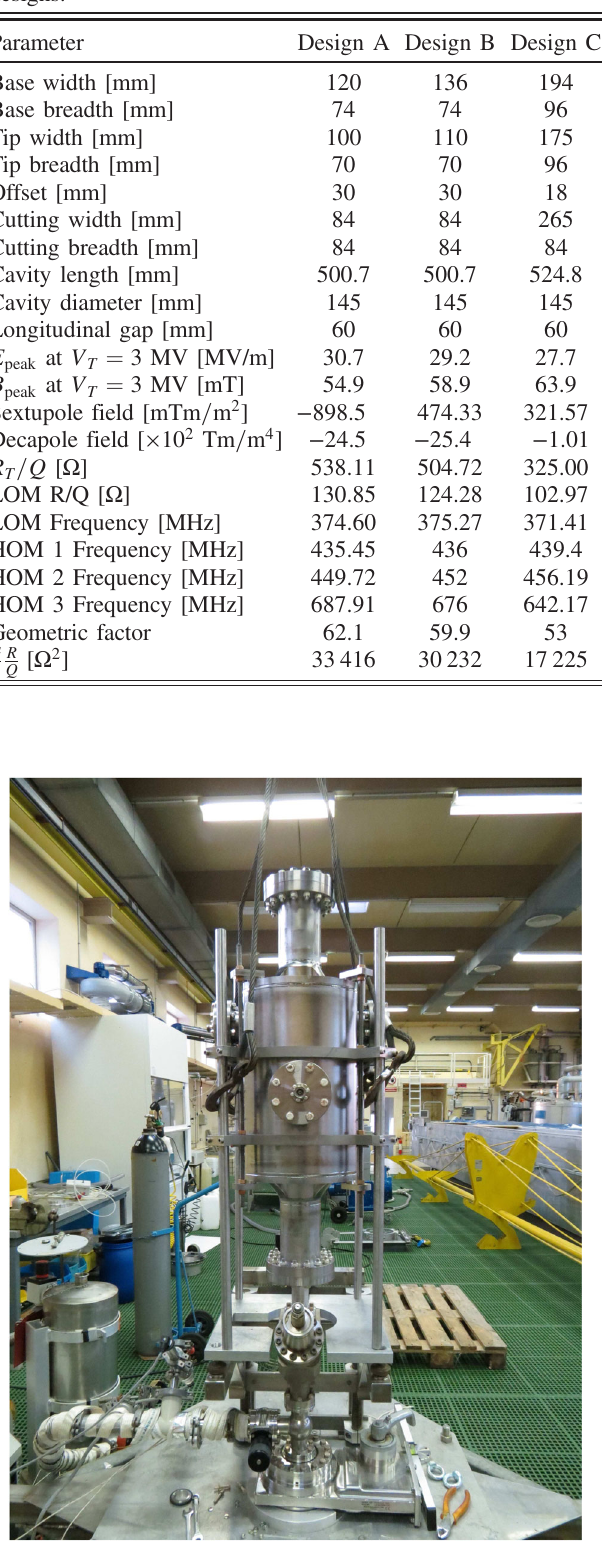
FIG. 19. The Niobium 4RCC prototype (Design A) dressed for cold rf testing.